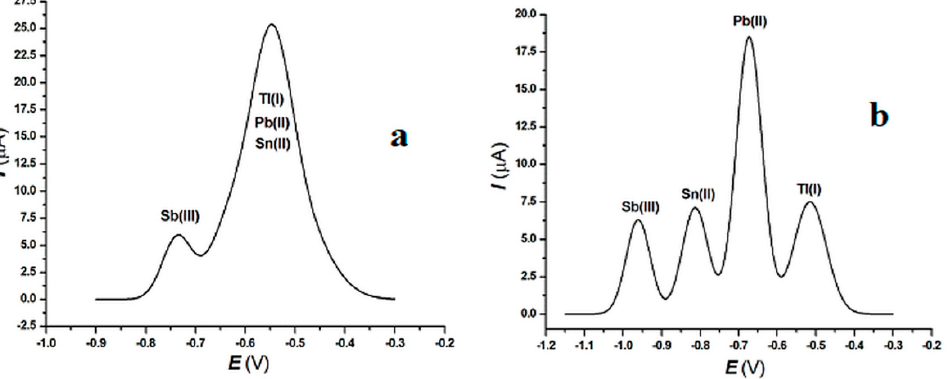
Figure 1. Square wave anodic stripping voltammograms of Tl(I), Pb(II), Sn(II) and Sb(III) in the absence of EDTA-Na 2 ( a ), and in the presence of EDTA-Na 2 ( b ). Concentrations ( µ g kg − 1 ): 69.3 [Tl(I)], 203.1 [Pb(II)]; 76.6 [Sn(II)]; 49.6 [Sb(III)]. Experimental conditions: see Section 2.3 “Voltammetry”. Supporting electrolyte: 0.5 mol L − 1 ammonium citrate buffer pH 6.5 + 7.3 ∙ 10 − 3 mol L − 1 EDTA-Na 2 .